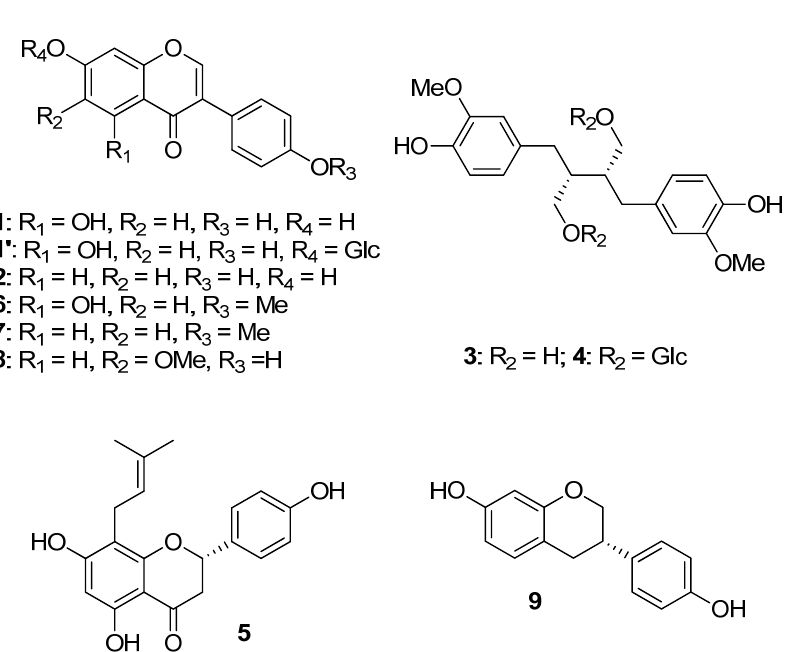
Figure 1. Structure of commonly reported phytoestrogens in food and dietary supplements. Phy- toestrogens are polyphenols such as isoflavones ( upper left ) and their metabolites ( bottom right ), enterolignans ( upper right ), or prenylated flavonoids ( bottom left ). Table 3. Examples of phytoestrogen dietary supplements. * Aglycone or glycoside form not